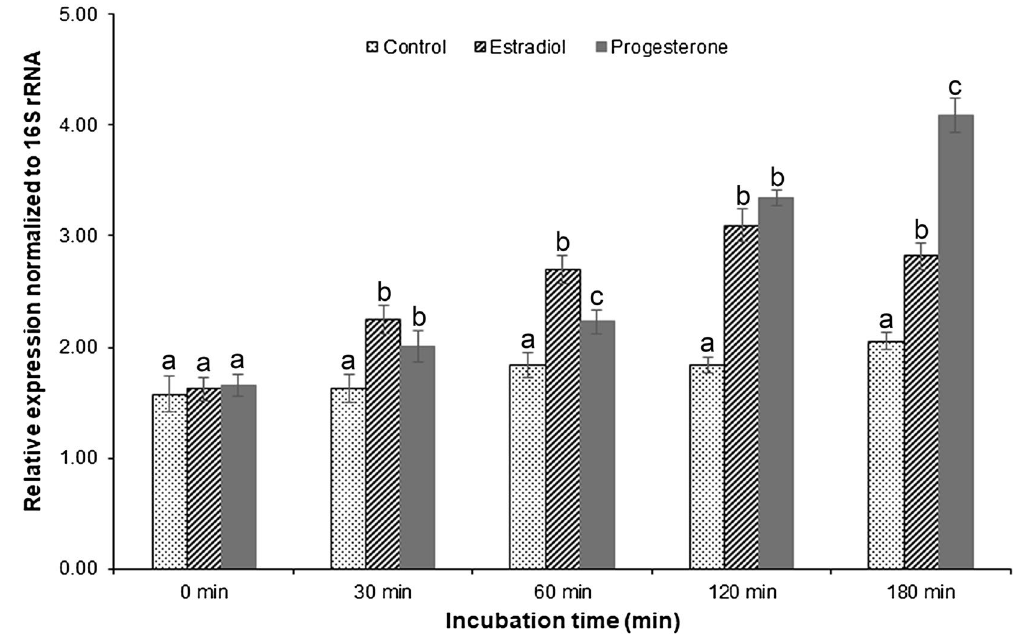
Figure 7. Effect of estradiol and progesterone on Vtg expression in ovarian tissue explants between 0 and 180 min. Relative gene expression levels of Vtg shown by quantitative real time-PCR (n = 3). Data were normalized against 16S rRNA and represented as mean ± S.D. Different letters indicate statistically significant different (p < 0.05) among the groups at the same incubation